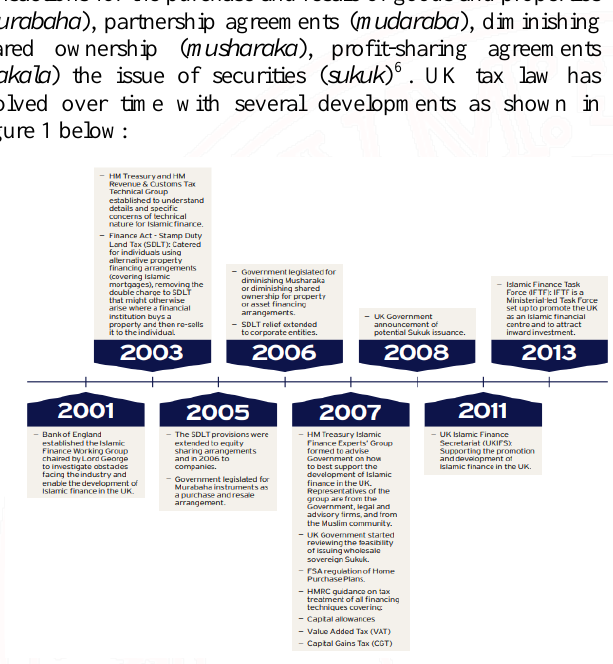
Figure 1: Regulatory Development of Islamic Finance in the UK [11]